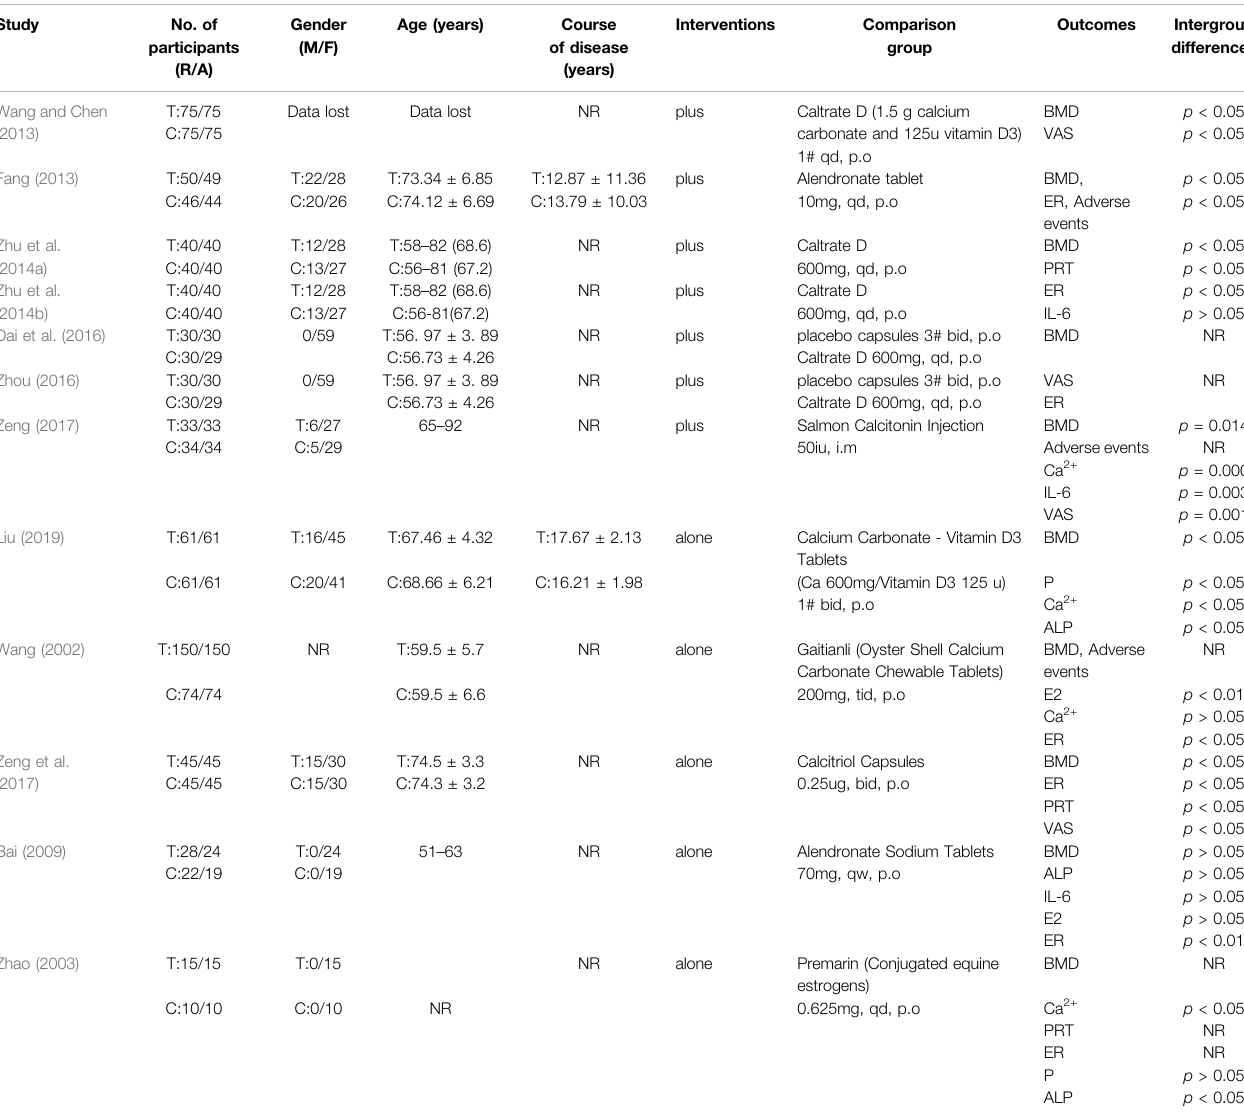
Outcomes Intergroup group differences